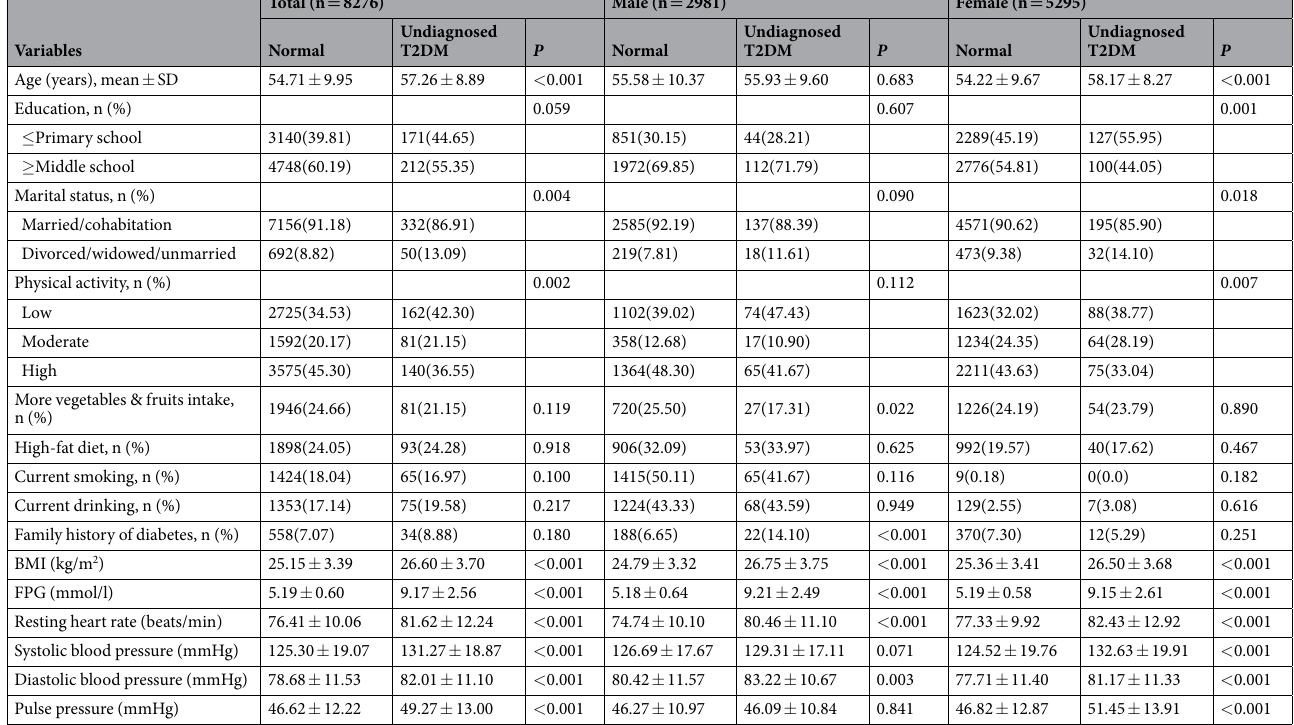
Table 1. General characteristics of the subjects (n = 8276). BMI, body mass index; FPG, fasting plasma